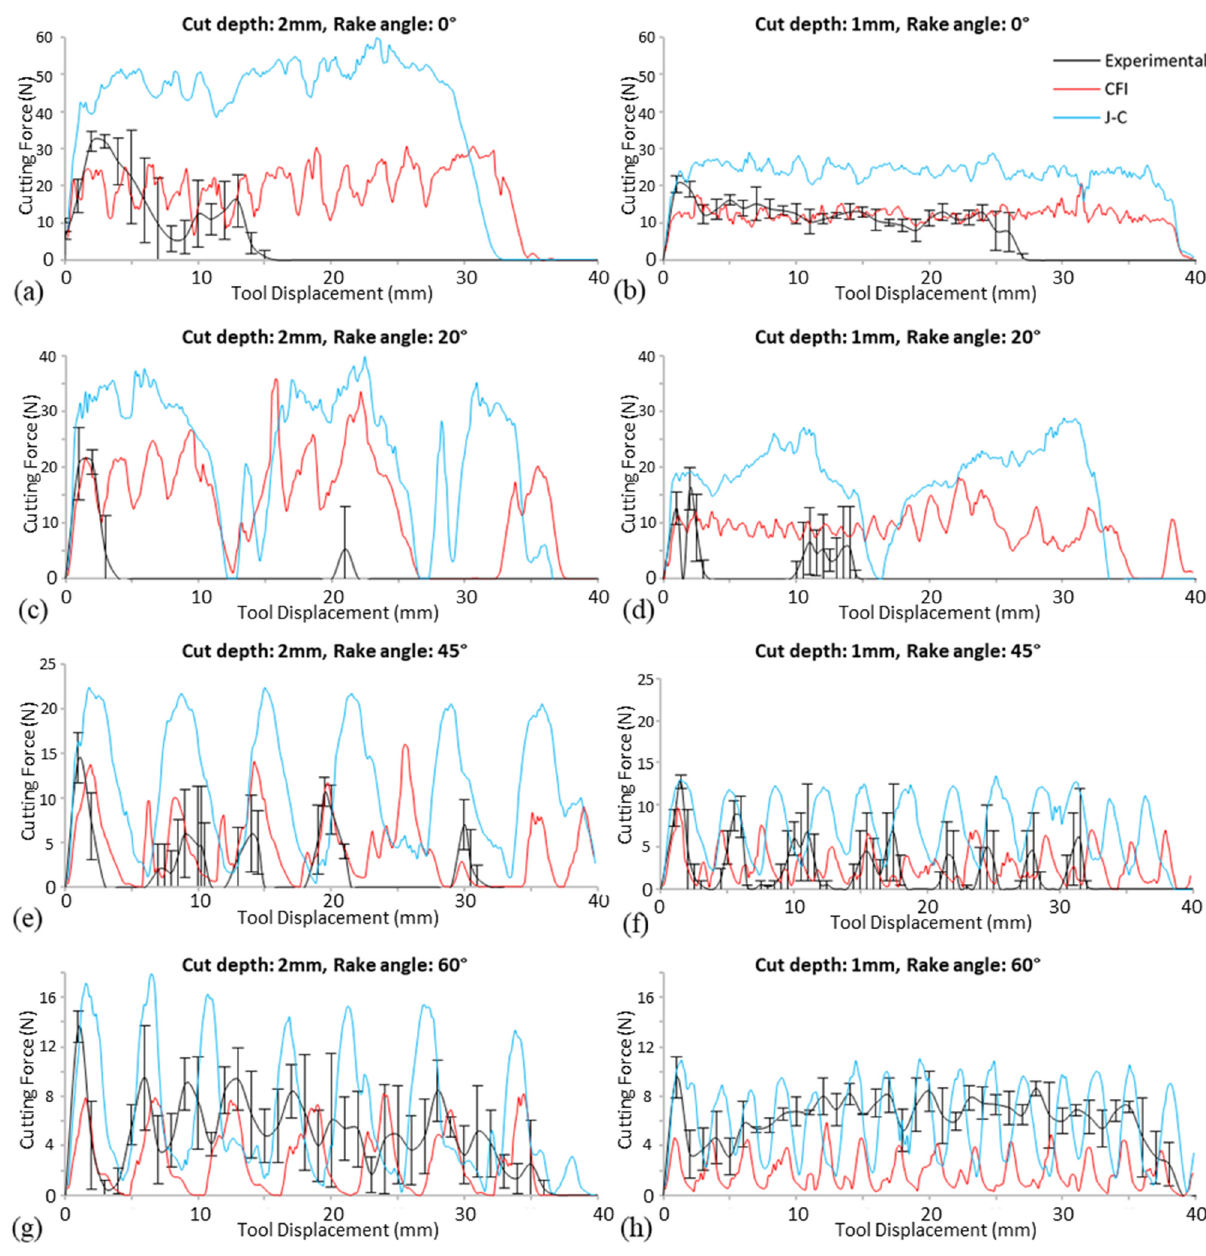
Figure 6. PU20 cutting force output ( a ) 𝛼 = 0°, ℎ = 2 mm ; ( b ) 𝛼 = 0°,ℎ = 1 mm ; ( c ) 𝛼 = 20°, ℎ = 2 mm ; ( d ) 𝛼 = 20°, ℎ = 1 mm ; ( e ) 𝛼 = 45°, ℎ = 2 mm ; ( f ) 𝛼 = 45°, ℎ = 1 mm ; ( g ) 𝛼 = 60°, ℎ = 2 mm ; ( h ) 𝛼 = 60°, ℎ = 1 mm .